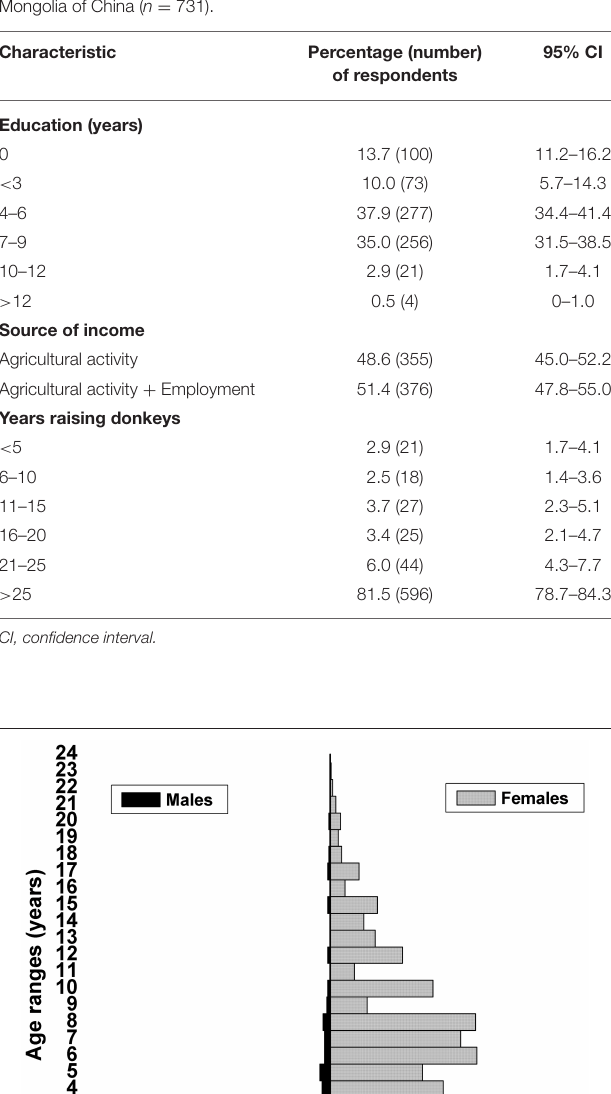
Uses of Donkeys The majority of donkeys were used for breeding (79.7%), and a large proportion was used for work, such as driving (61.6%), packing (3.4%) and agricultural operations during drafts (69.1%). Only 11.4% of the donkeys were used for meat and hide production ( Table 3